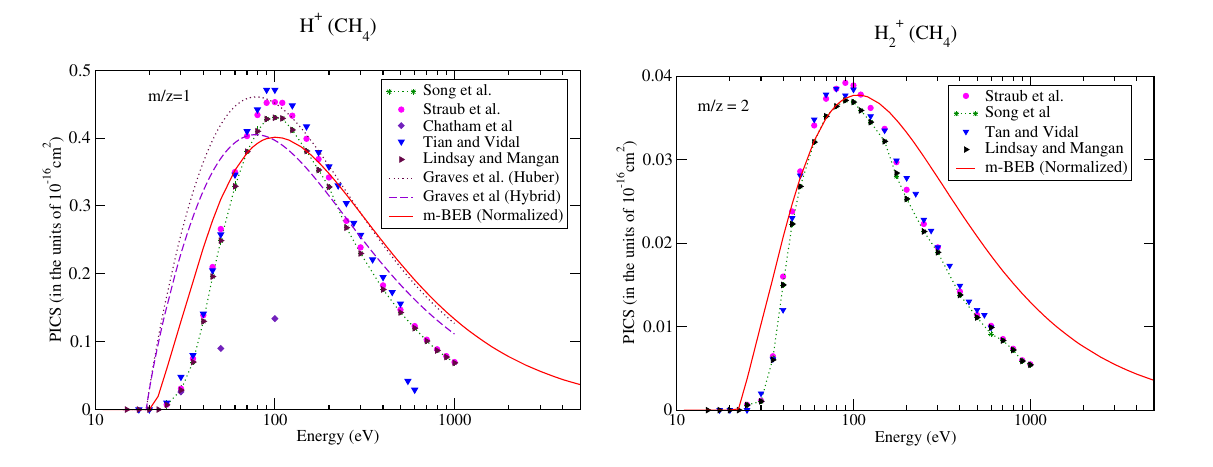
Figure 4. Caption same as Figure 1 but for ( a ) m / z = 1, ( b ) m / z = 2. Line curve, m-BEB; Graves et al. [26] from Huber model; dots with dashed curve; Graves et al. [26] from hybrid model; triangles inverted, Tian and Vidal [45]; dots with star, recommended data of Song et al. [48]; dots, circles, experimental data of Straub et al. [50]; diamonds, Chatham et al. [57]; triangles, Lindsay